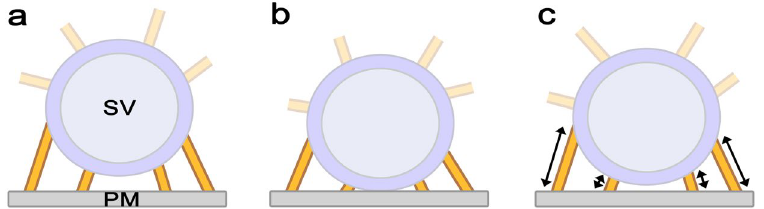
Figure 1. Schematic diagrams of synaptic vesicles (SVs) in the vicinity of the presynaptic membrane (PM) at active zones and a stochastic active zone material (AZM) mediated SV docking and priming model. Two schematic diagrams on the left depict SVs in the vicinity of the PM typically found at active zones. Multiple AZM macromolecules (yellow) are associated with the SVs, and several AZM macromolecules directly link the SVs to the PM while other AZM macromolecules link the SVs to the PM indirectly. It should be noted that non-AZM macromolecules are also found linking the SVs to other SVs 15, 20 , which are not shown here. ( a ) An undocked SV near the PM associated with multiple AZM macromolecules directly linking the SV to the PM (golden) and other AZM macromolecules (semitransparent golden). ( b ) A docked SV with the PM associated with multiple AZM macromolecules (golden) directly linking the SV to the PM and other AZM macromolecules (semitransparent golden). ( c ) A stochastic AZM-mediated SV docking and priming model based on the hypothesis that the AZM macromolecules directly linking SVs to the PM randomly shorten and lengthen. The model proposes that the SV docking and priming are regulated by the forces generated via the structural changes of the AZM macromolecules that contain, at least in part, proteins crucial for SV fusion with the